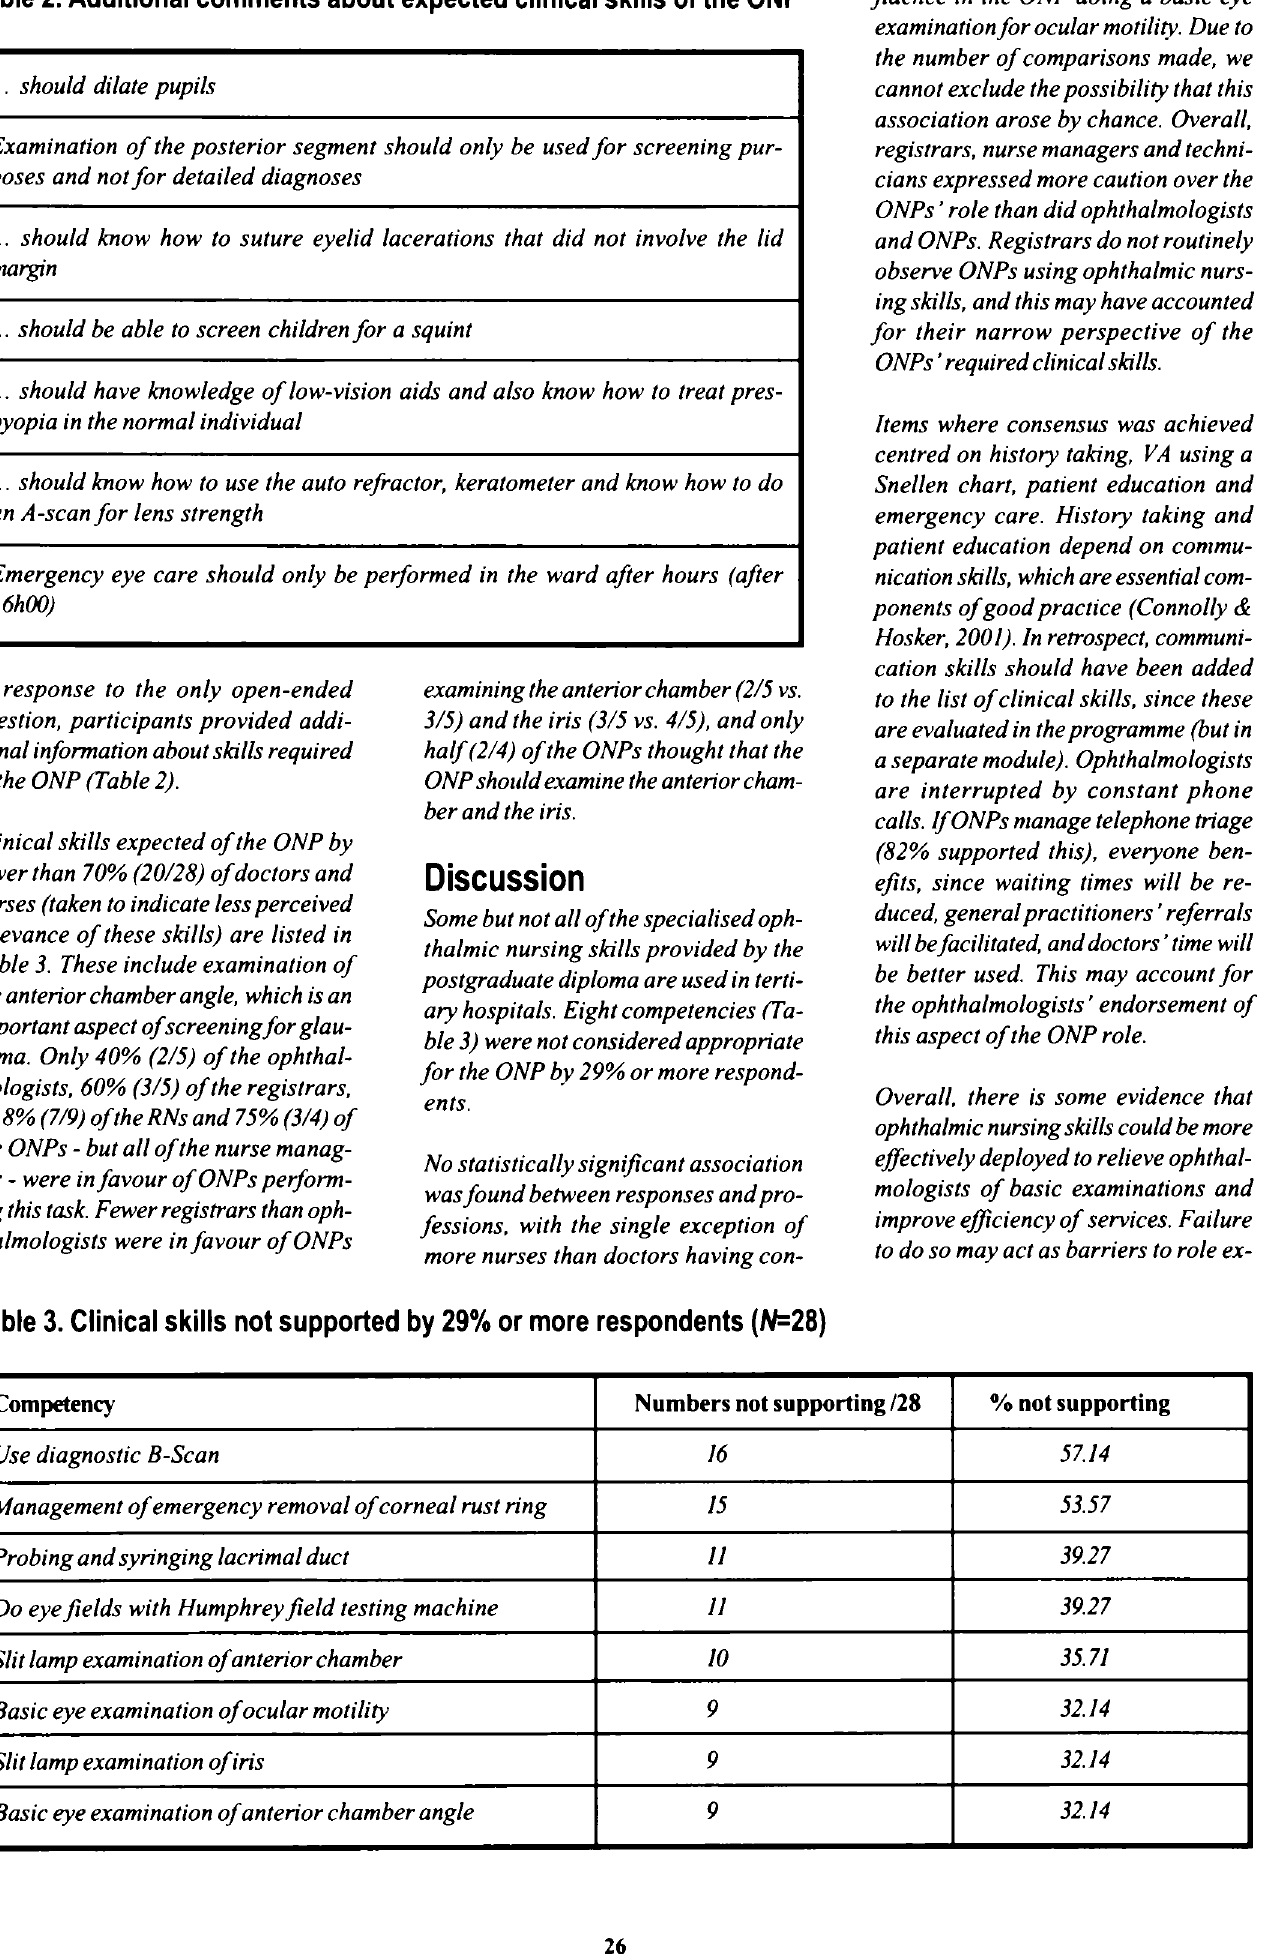
Table 2. Additional comments about expected clinical skills of the ONP